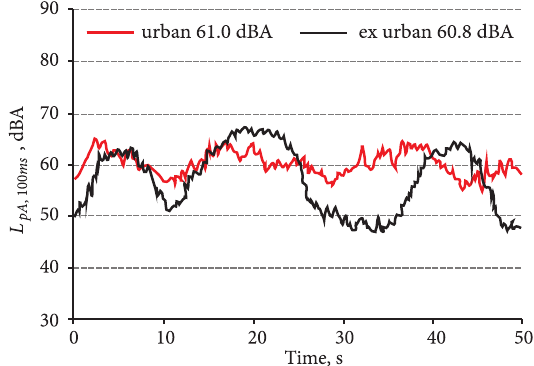
Fig. 2. Time histories of typical sound levels of short period (50 s) of vehicle passing by in suburban and urban living areas at a distance of 50 m from the road with the generated of about 61 dBA the same equivalent levels (Jagniatinskis et al.